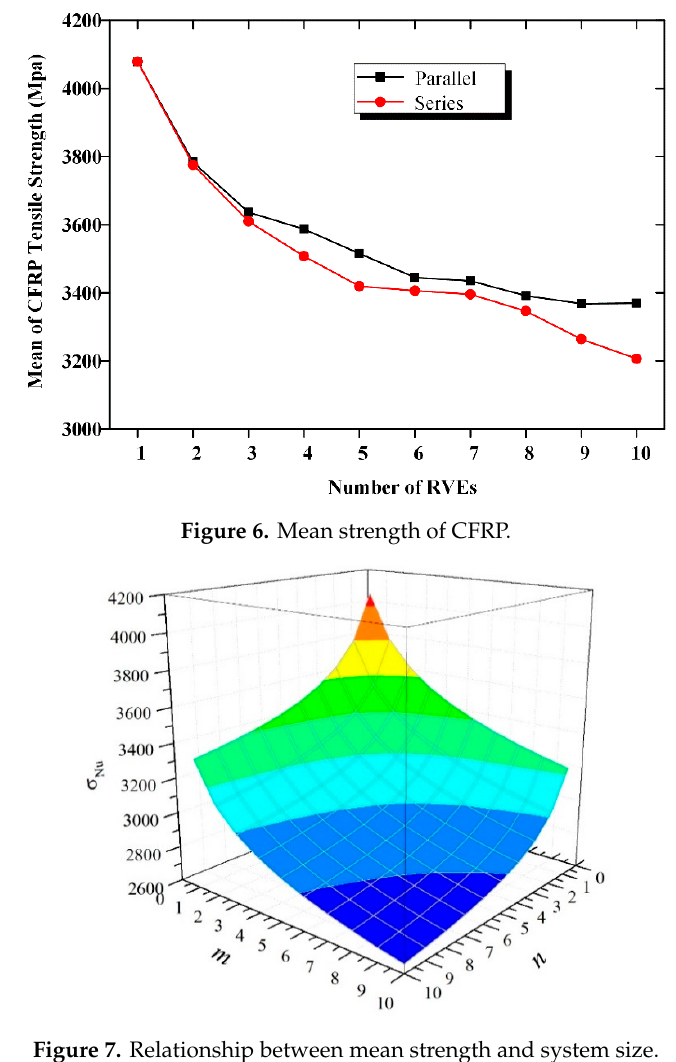
Figure 7. Relationship between mean strength and system size.